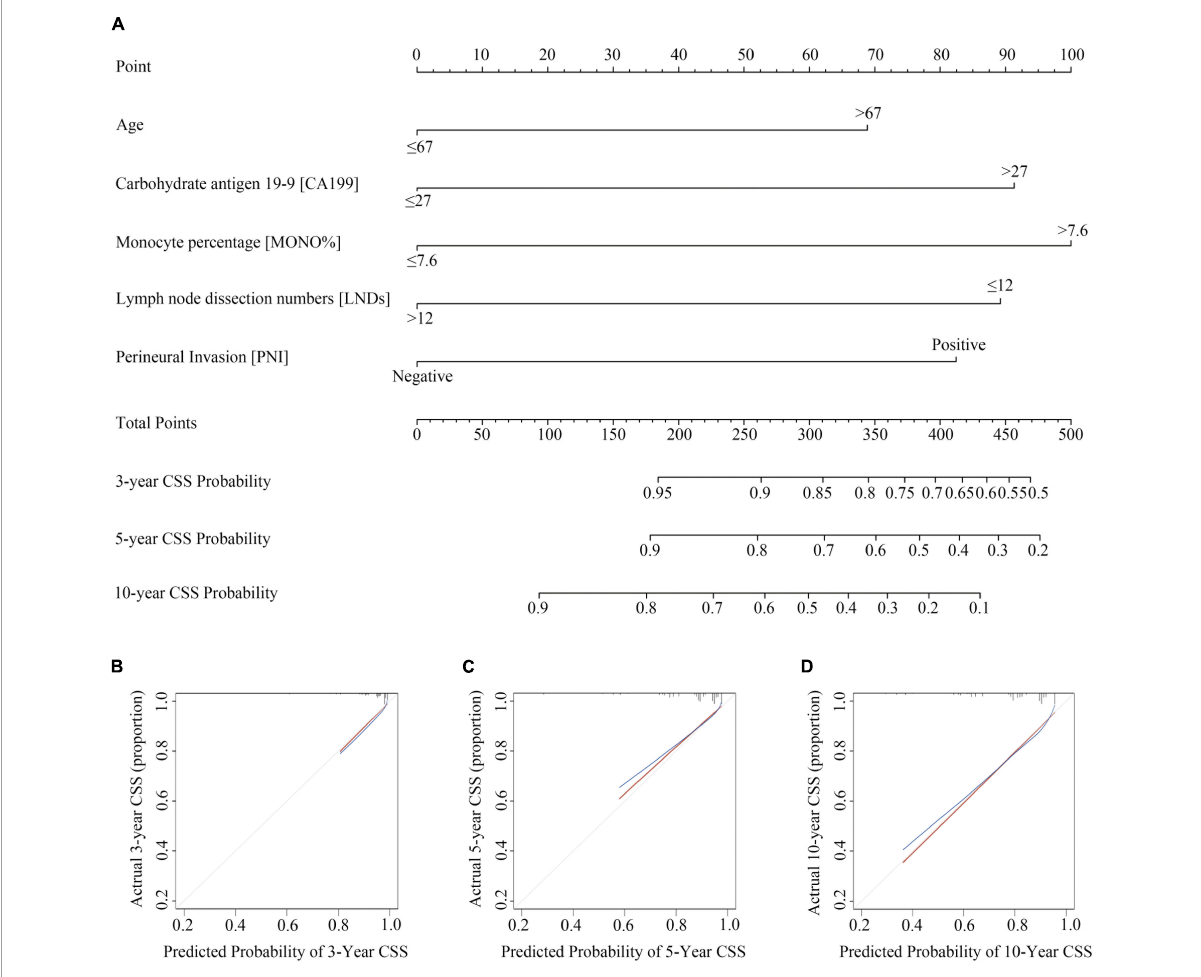
FIGURE2 Construction and validation of Nomogram for cancer specific survival probability in pT3N0M0 rectal cancer patients. (A) The nomogram was developed with age, monocyte percentage (MONO%), carbohydrate antigen 19-9 (CA199), lymph node dissection numbers (LNDs), and perineural invasion (PNI); (B–D) calibration curves of the CSS nomogram, indicating the consistency between predicted and observed 3-, 5-, and 10-year